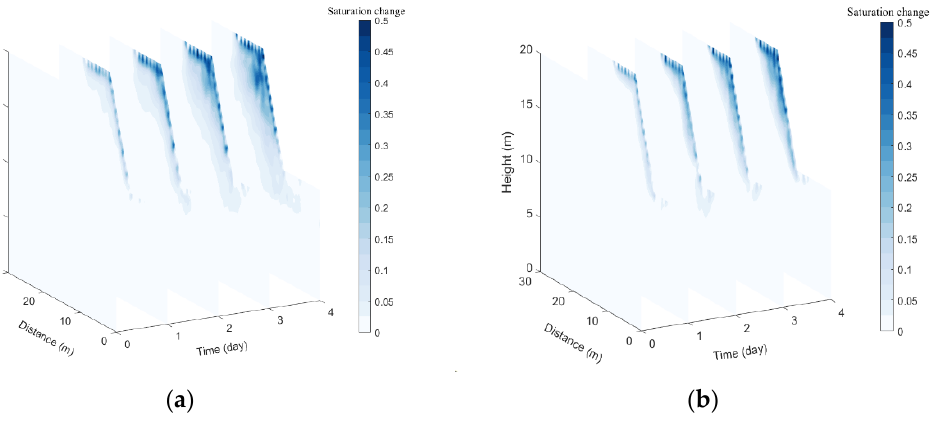
Figure 11. The spatial and temporal evolution of saturation obtained by inversion under the combi- nation of multiple conditions: ( a ) Wenner array; ( b ) Dipole-Dipole array.